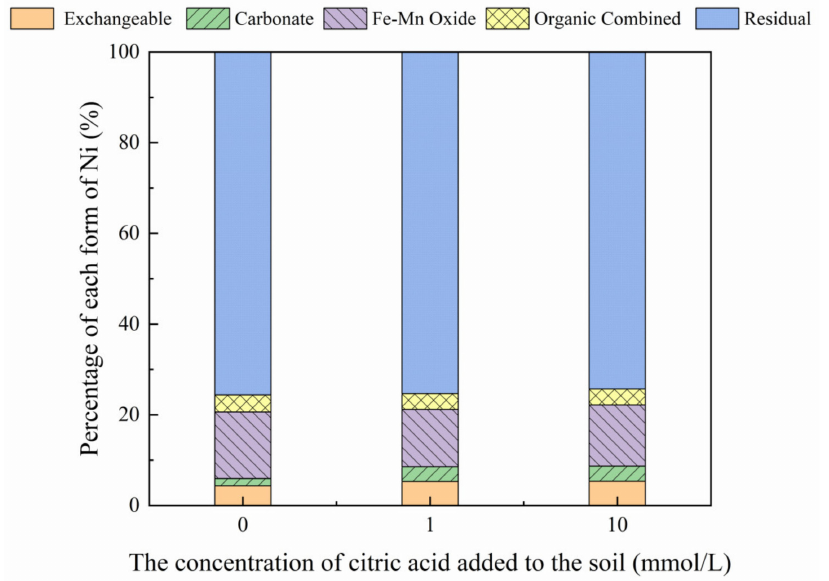
Figure 2. Distribution of different Ni forms after the addition of citric acid (0, 1, 10 mmol/L) to the air-dried mine